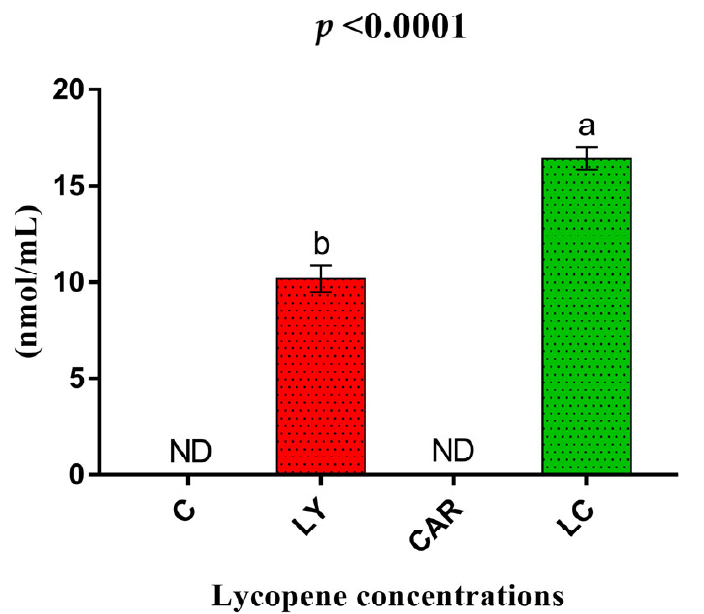
Figure 3. Serum Lycopene Levels. Data are presented as mean value ± SEM ( n = 6). Values without the same letter (a, b, and ND) represent statistically significant differences ( p < 0.05). Abbreviations: C, Roosters fed a basal diet; LY, Roosters fed a basal diet supplemented with 400 mg/kg Lycopene; CAR, Roosters fed a basal diet supplemented with 150 mg/kg L-Carnitine; LC, Roosters fed a basal diet supplemented with (400 + 150) mg/kg Lycopene and L-Carnitine in combination. (ND) pointed to not detected.